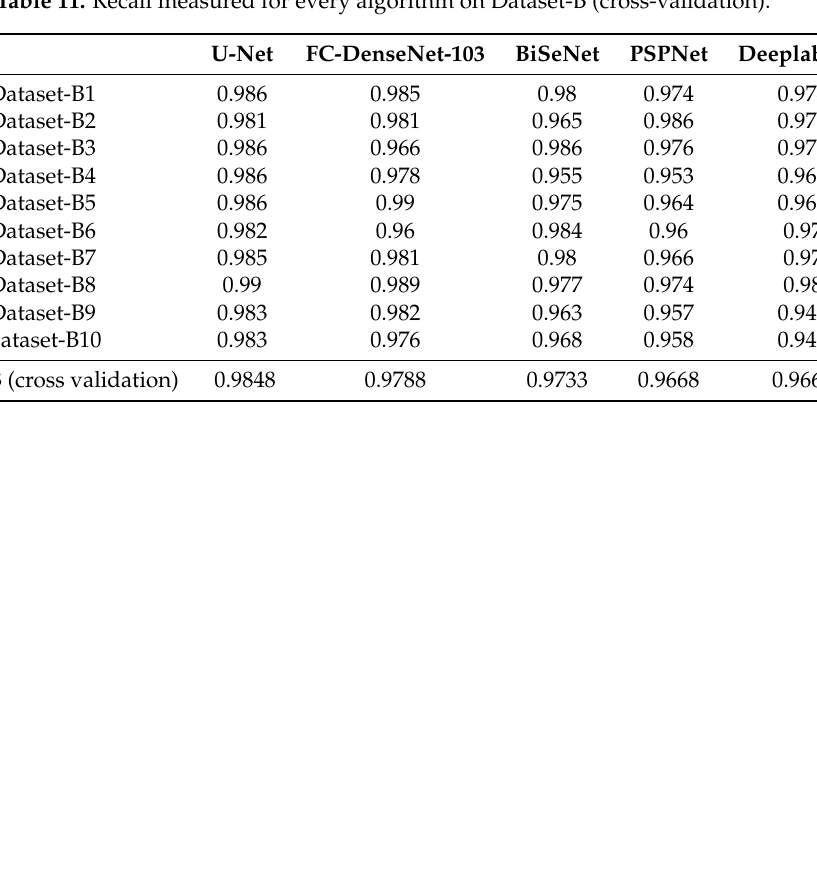
Table 11. Recall measured for every algorithm on Dataset-B